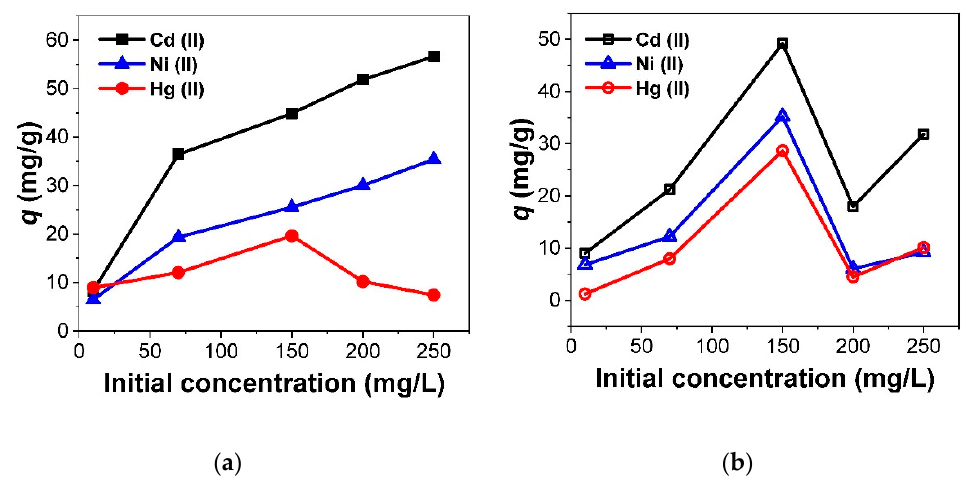
Figure 6. Effect of initial metal concentration on the adsorption capacity of MAAC beads for ( a ) mono-metal and (mean SD ± 1.45) ( b ) ternary experiment at pH 4.5 (mean SD ± 1.27).